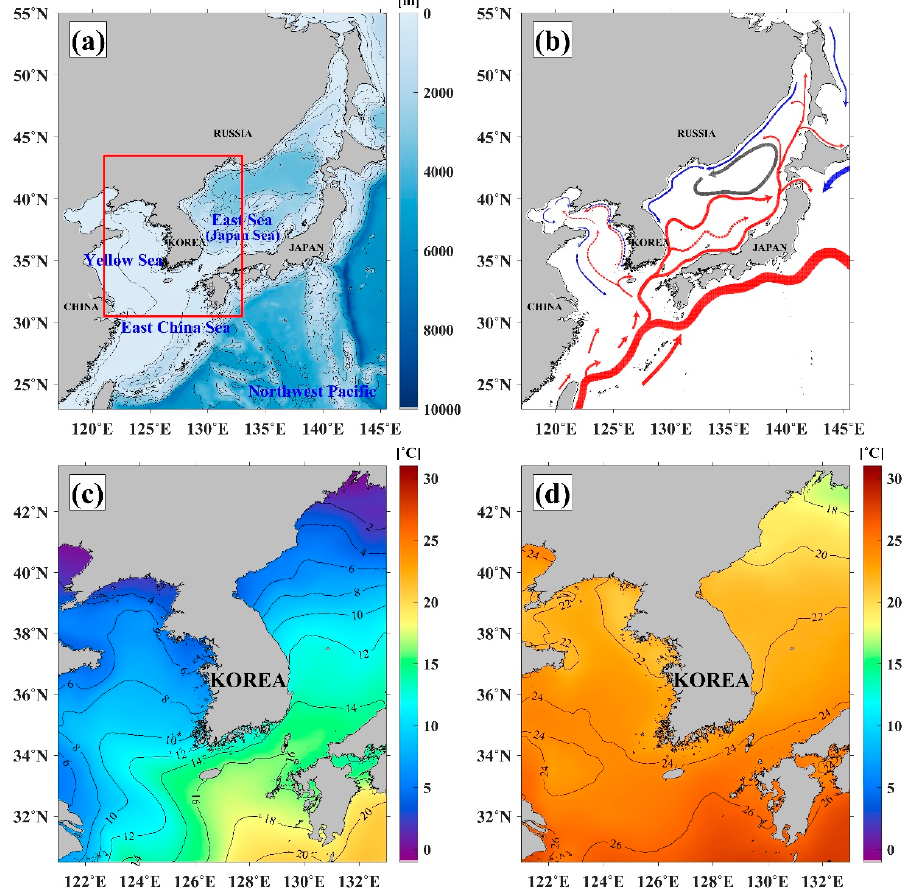
Figure 1. ( a ) Location of the study area with contours of the water depth (m) in the seas around the Northeast Asia including China, Japan, Korea, and Russia, which red box indicates the study area, ( b ) a schematic current map with cold (blue) and warm (red) currents [58], and monthly mean of sea surface temperature (SST) climatology (°C) estimated from the Operational Sea Surface Temperature and Sea Ice Analysis (OSTIA) SST database in the study area from 2002 to 2015 in ( c ) winter (January) and ( d ) summer (July).